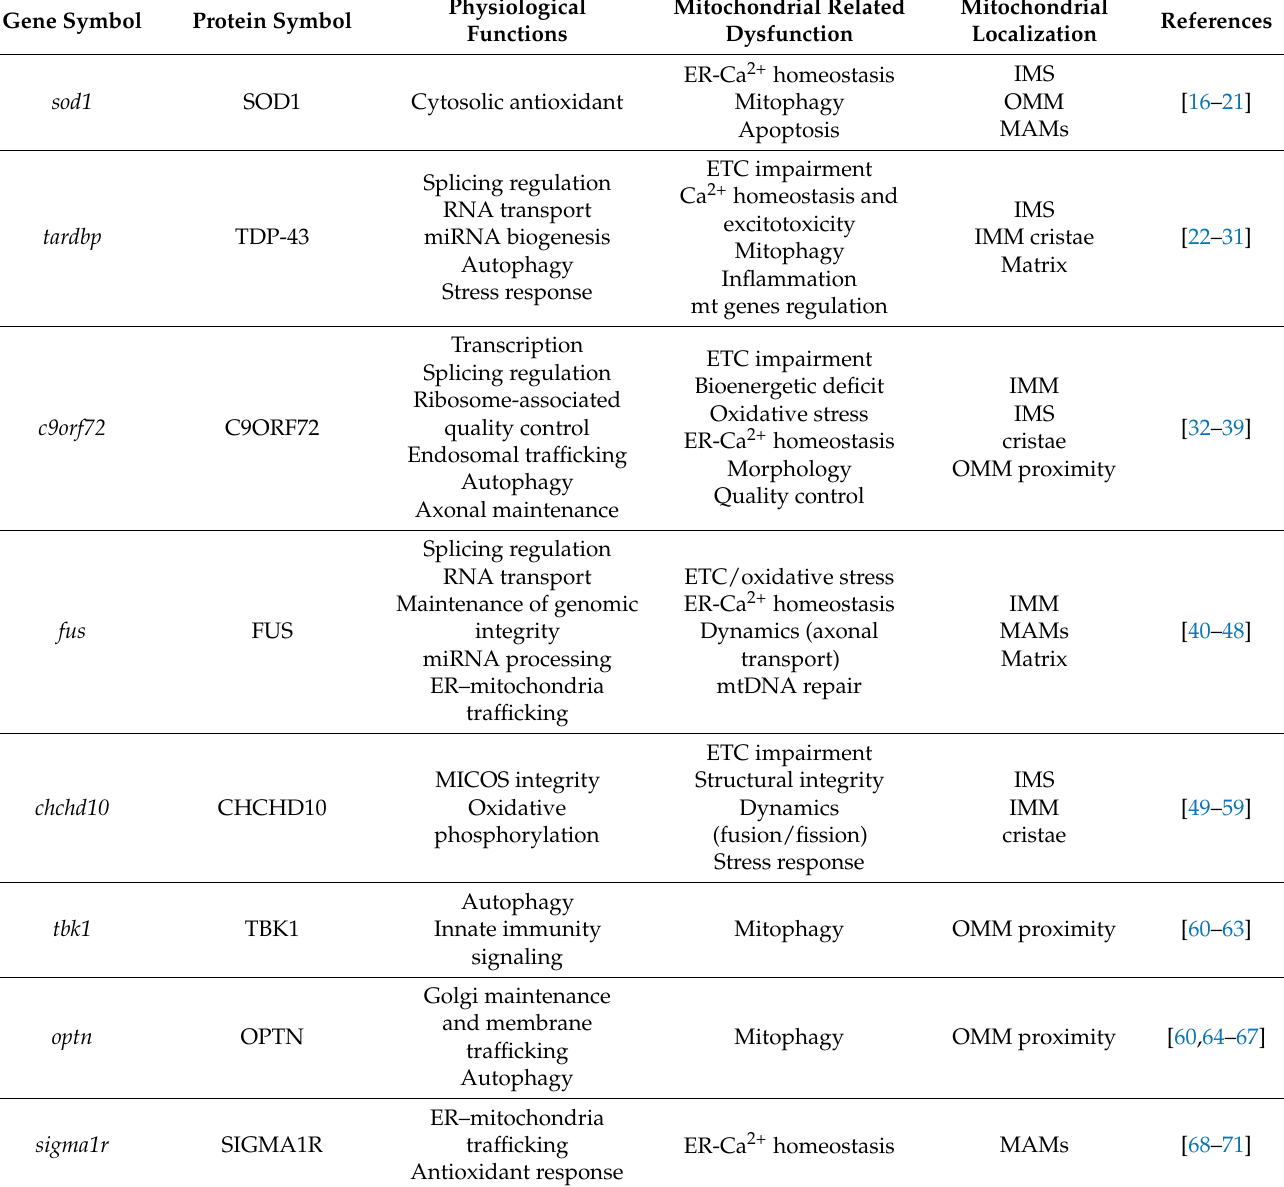
Table 1. Impact of ALS-related genes on mitochondrial functions. Pathogenic variants of ALS-proteins associated with altered mitochondrial